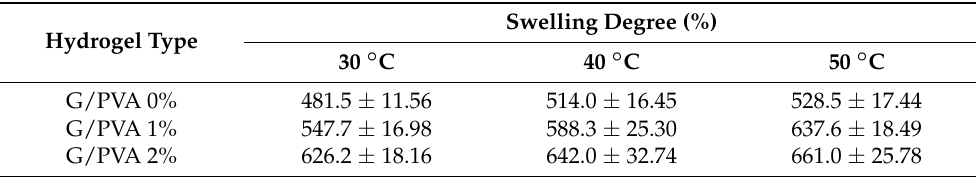
Table 4. The swelling degree (SD) of gelatin and gelatin/PVA hydrogels was determined after 24 h of incubation at different temperatures.